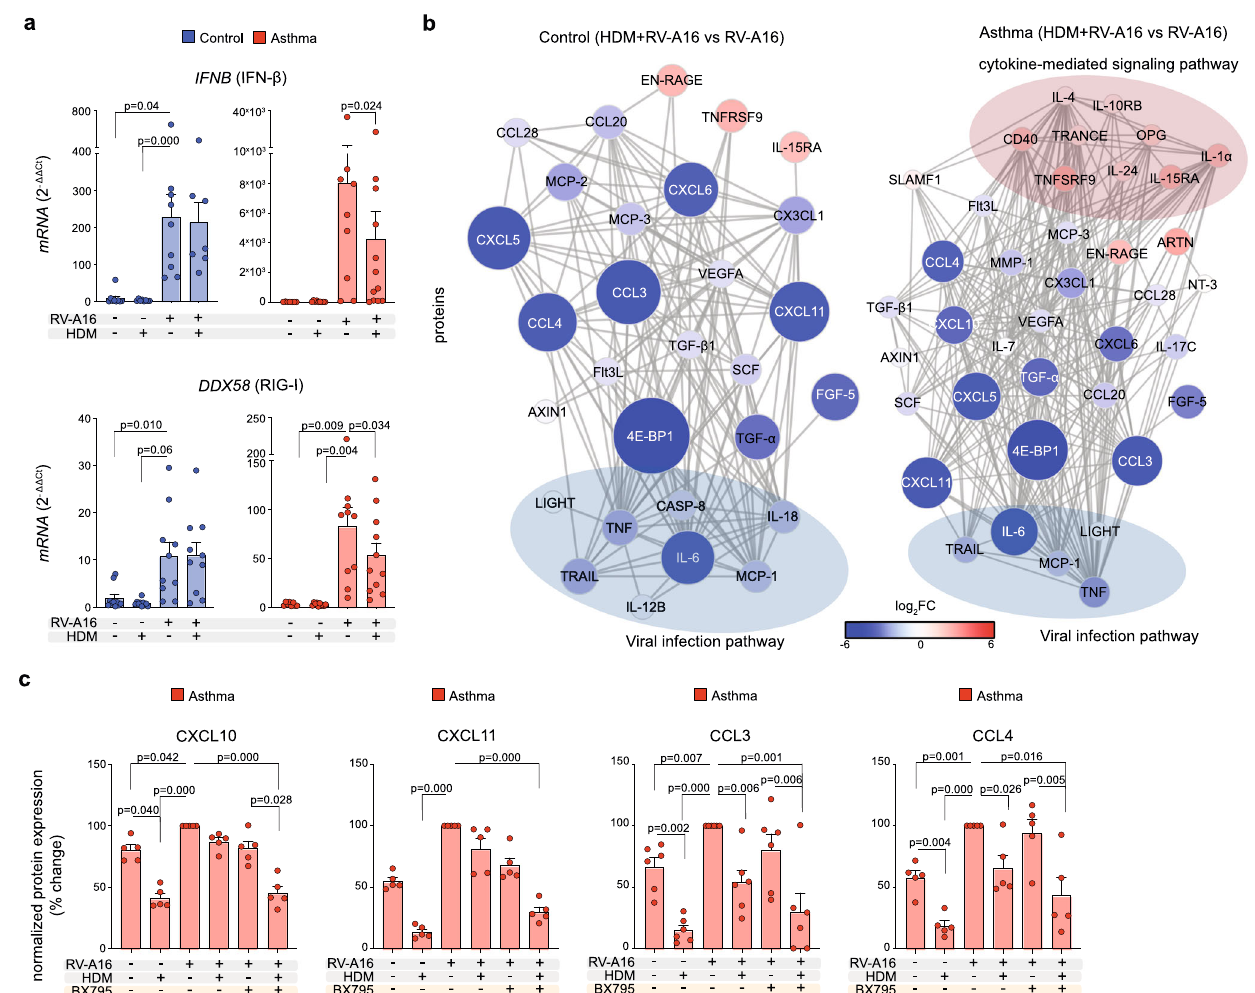
Fig. 5 | House dust mite impaired interferon responses in rhinovirus-infected bronchial epithelium of patients with asthma. a mRNA expression of IFNB (IFN- β ) (upper panel) in in vitro-cultured HBECs from controls ( n =9, vehicle, RV-A16; n =8, HDM; n =7, HDM+RV-A16) and asthma ( n =7, vehicle; n =9, HDM, RV-A16; n =12, HDM+RV-A16), and DDX58 (RIG-I) (lower panel) in in vitro-cultured HBECs from controls ( n =10) and asthma ( n =8, vehicle; n =9, HDM, RV-A16; n =11, HDM+RV-A16) assessed using RT-PCR and presented as relative quanti fi cation (RQ=2 - ΔΔ Ct ) as compared to the vehicle condition. b Visualization of interaction network of signi fi cant proteins secreted to the apical compartment in in vitro- culturedHBECsfromcontrolindividuals( n =5,leftpanel)andpatientswithasthma ( n =8, right panel) after in vitro treatment with HDM+RV-A16, when compared to RV-A16 infection alone assessed with PEA targeted proteomics. Network nodes represent log 2 FC of signi fi cantly upregulated (red), and downregulated (blue) proteins; proteins not interacting with each other are not shown. Edges represent protein-protein interactions. Proteins enriched in viral infection or cytokine-